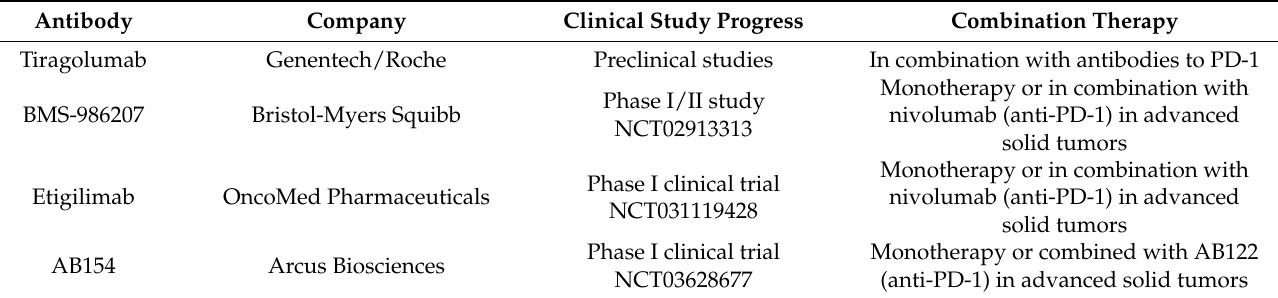
Table 2. mAbs targeting TIGIT for immunotherapeutic use